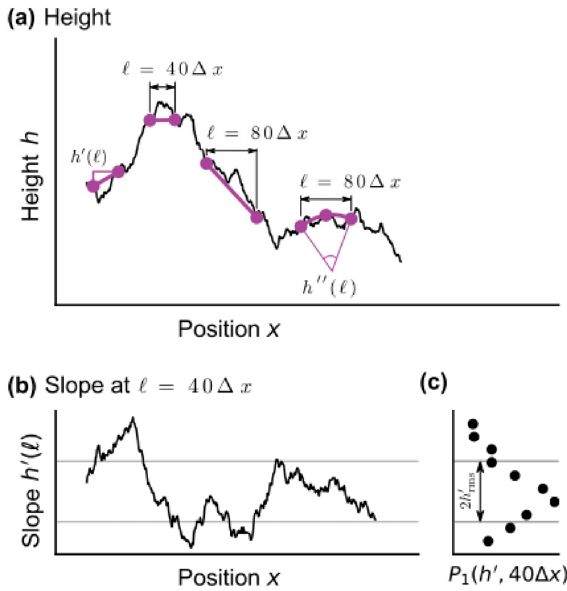
Fig. 81 Illustration of the basic idea behind the scale-dependence roughness parameters [966]. Reproduced with permission from Ref. [966], © The author(s),